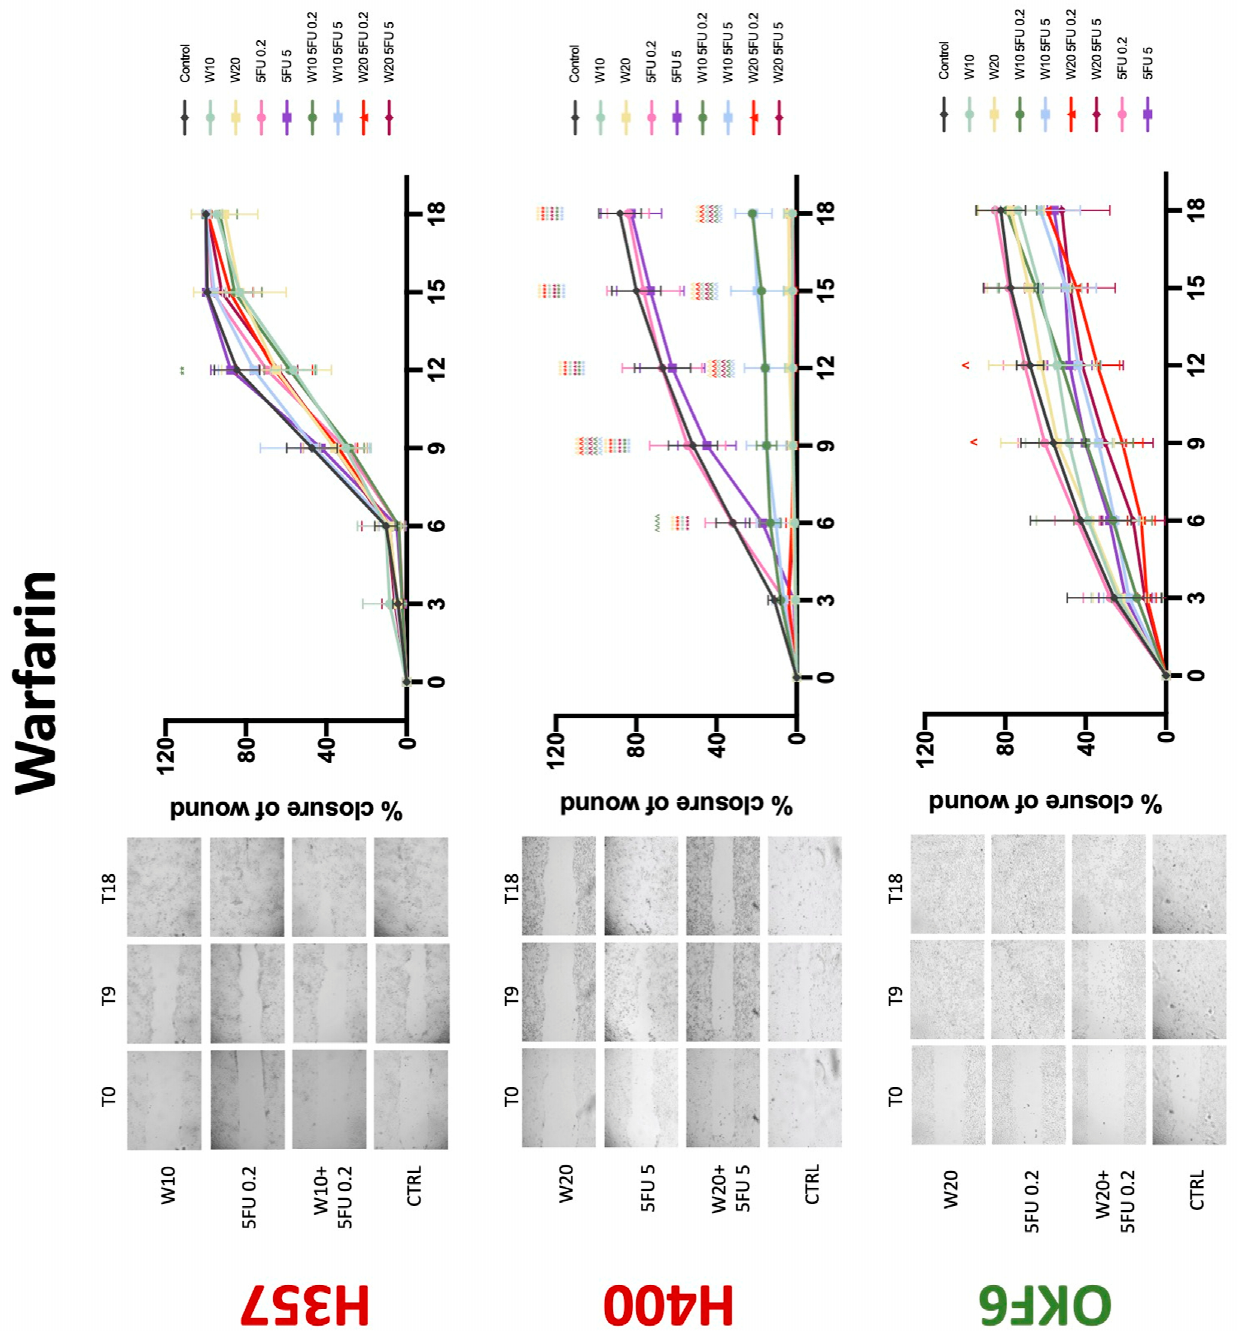
Figure 7. Wound healing assay . The effect of (10/20 μ M) warfarin and (0.2/5 μ g/mL) 5-FU on H357, H400, and OKF6 cell migration. Data are represented as mean ± SD. Statistical significance is given as follows: ** p < 0.01, **** p < 0.001; (*) compared to control group; ^^^^ p < 0.001; (^) compared to respective 5 - FU groups.